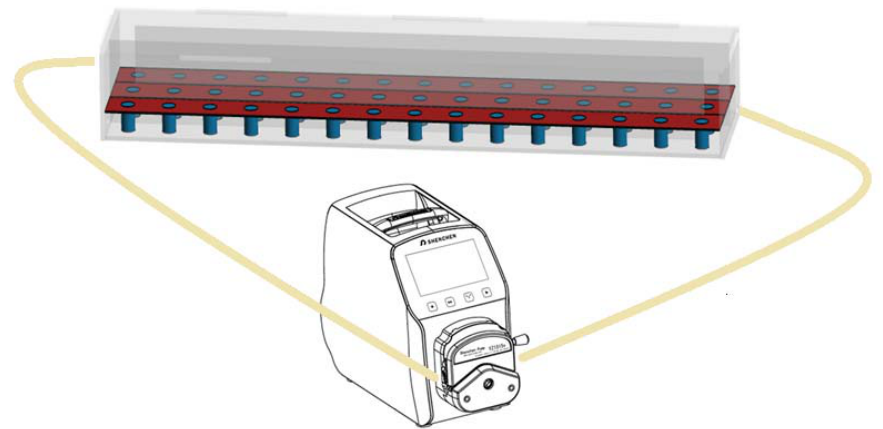
Figure 2. Experimental device for studying the concrete specimens’ deterioration after coating, due to the presence of H 2 SO 4 (0.2 M) in comparison with water. The acrylic glass device allows the circulation of solution through an S ‐ shaped route.